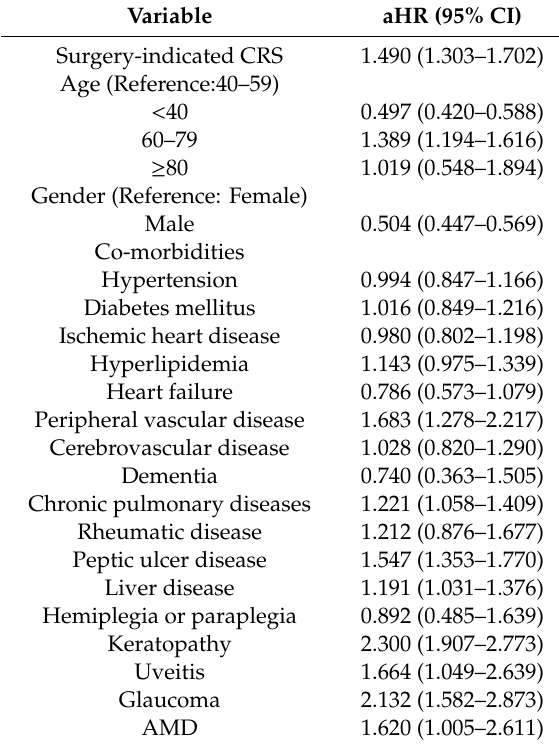
Table 3. Multiple Cox proportional hazard regression for estimation of adjusted hazard ratios on dry eye